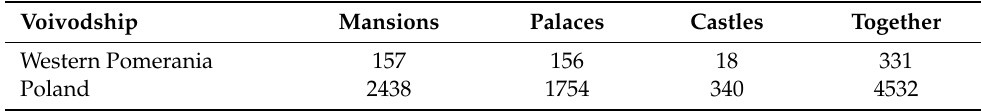
Table 1. Castles, palaces and manors in Poland and the West Pomeranian Voivodeship (This list does not include city